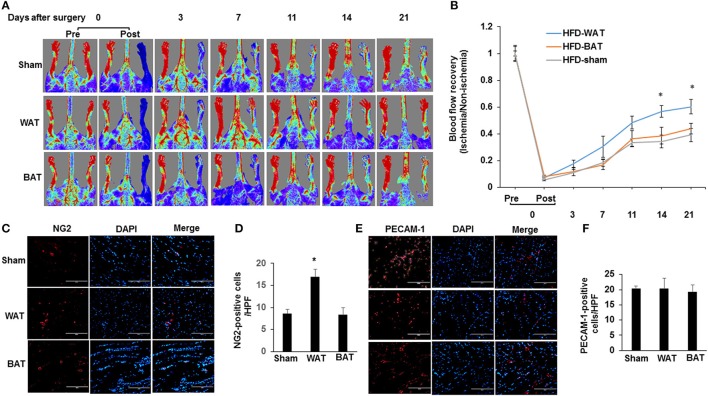
WAT transplantation reverses HFD-impaired blood flow perfusion after femoral artery ligation. (A) Representative laser Doppler images of mouse hindlimbs at indicated time points after femoral artery ligation. Pre and post indicate immediately before and after surgery, respectively. Red color denotes normal perfusion. (B) Mean ratio of blood flow in ischemic and non-ischemic hindlimb foot pads for all animals at indicated the time points (n = 9 per group; *P < 0.05 vs. BAT-transplanted and sham mice). (C) Representative images of arterioles as assessed by anti-NG2 immunostaining in ischemic adductor muscles 21 days after femoral artery interruption. Distance bars, 100 μm. (D) The mean arteriole density in ischemic adductor muscles was significantly greater in WAT-transplanted mice (n = 9 per group; *P < 0.05 vs. BAT-transplanted and sham mice). (E,F) Representative images of capillary as assessed by anti-PECAM-1 immunostaining in ischemic gastrocnemius muscles 21 days after femoral artery interruption. Distance bars, 100 μm. Mean capillary density in ischemic gastrocnemius muscle did not differ significantly between groups (P > 0.5). HPF indicates high-power field.